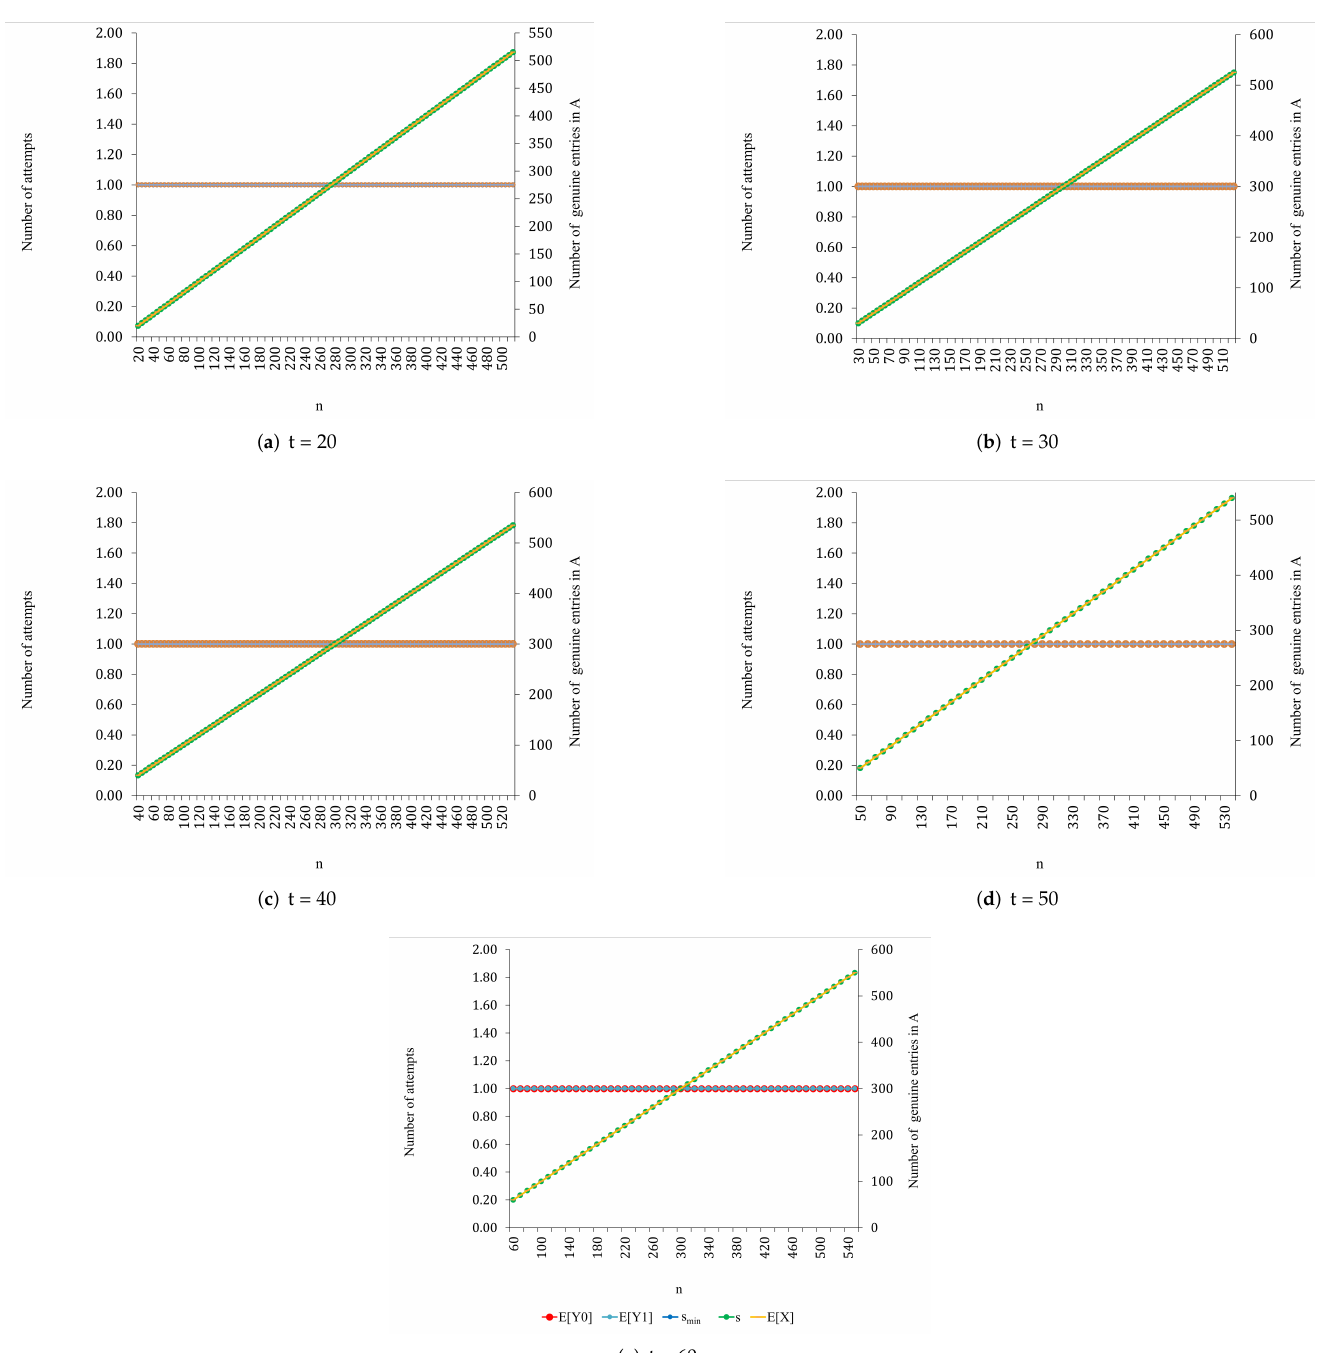
Figure 6. Results obtained for p min = 1 ∈ P , t ∈ T , and proper values of n